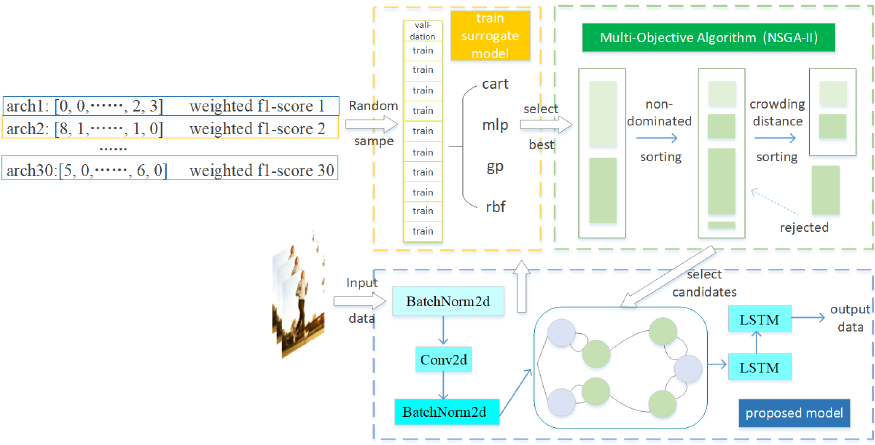
Figure 1. The proposed HAR framework based on NAS with surrogate model and NSGA-II.